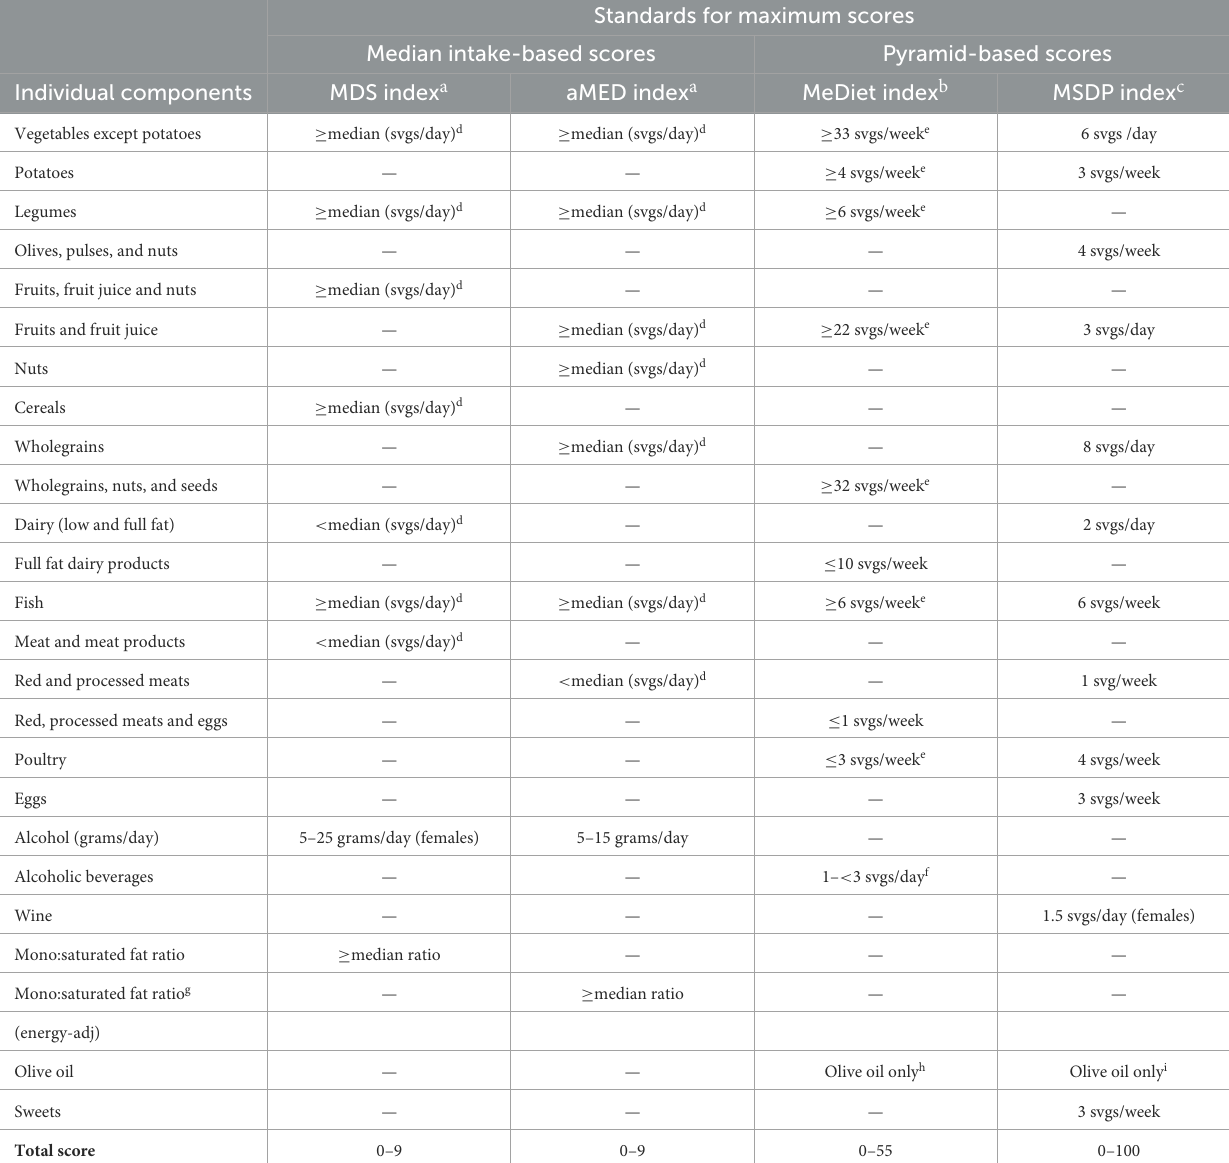
TABLE 1 Standards for maximum scores on each Mediterranean diet index.